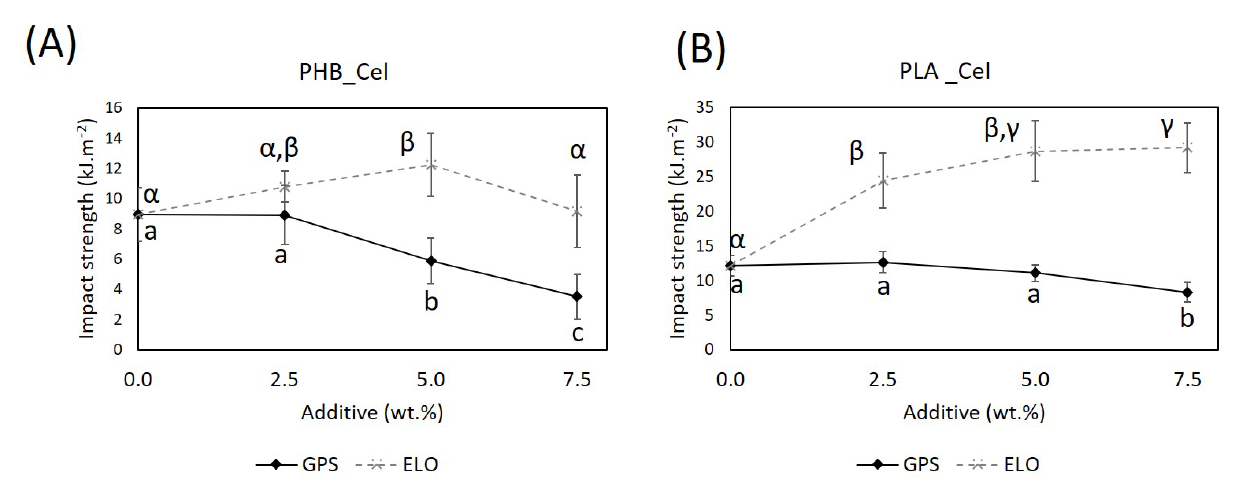
Figure 5. Impact strength of the PHB- ( A ) and PLA-based composites ( B ) without additives and with different loads of GPS and ELO additives (the lines are for visual guidance only). Different letters (a,b,c) or (α,β,γ) indicate statistically significant differences ( p < 0.05).